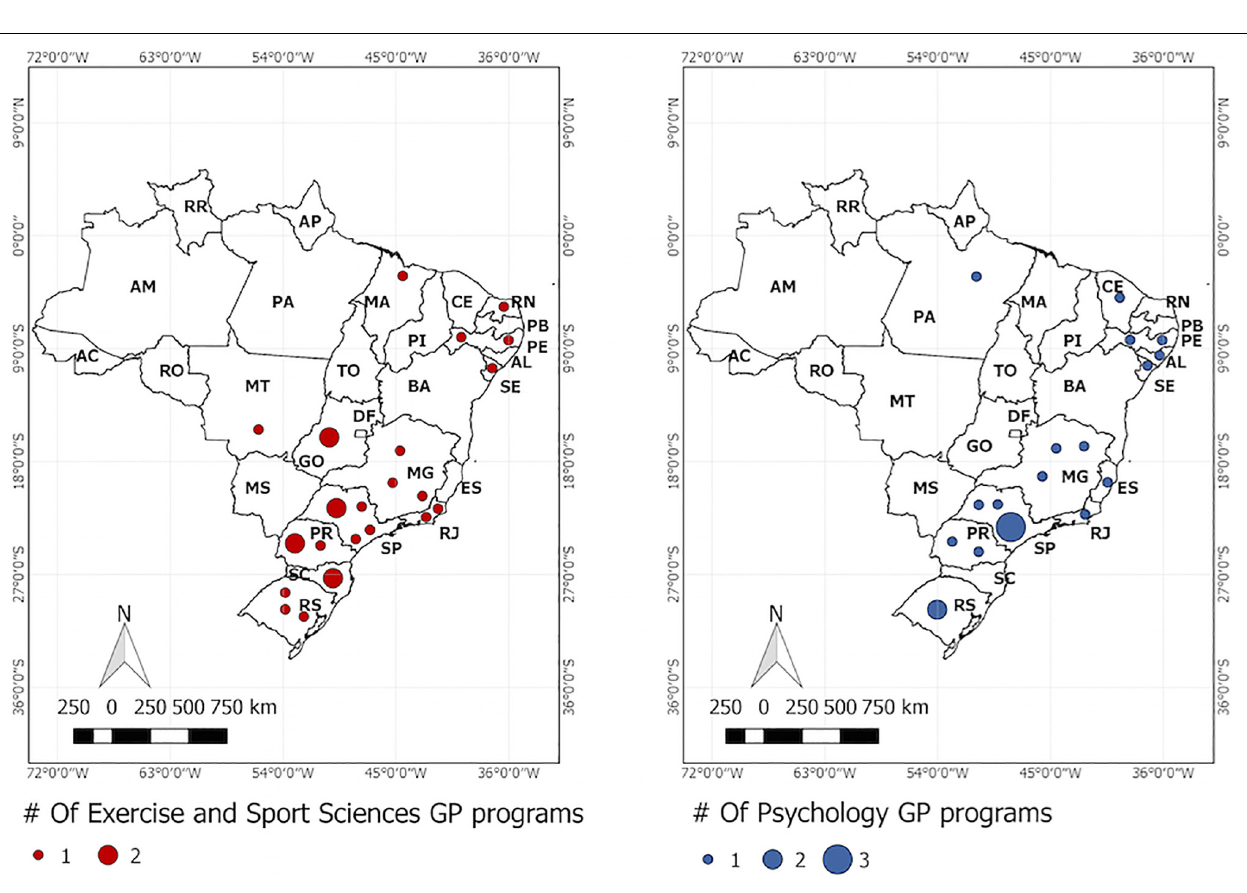
Frontiers in Psychology |